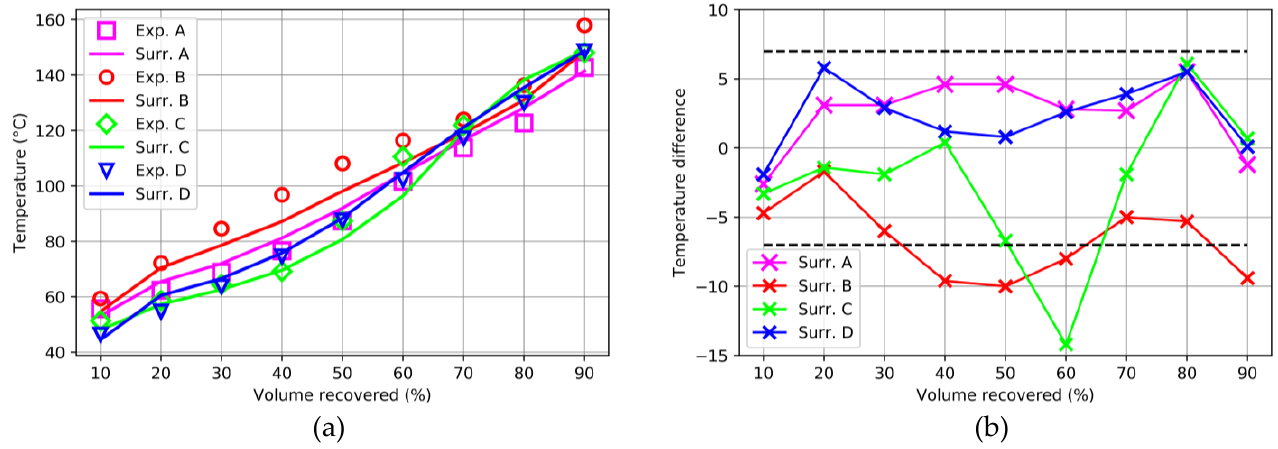
Figure 6. Comparison of the distillation curve of the experimental gasoline (markers) and of the optima surrogate (solid line) for the four validation surrogates A, B, C, D ( a ). The distillation temperature difference between surrogate and experimental values are also shown ( b ), dashed black lines are placed at ± 7 °C as acceptability interval.